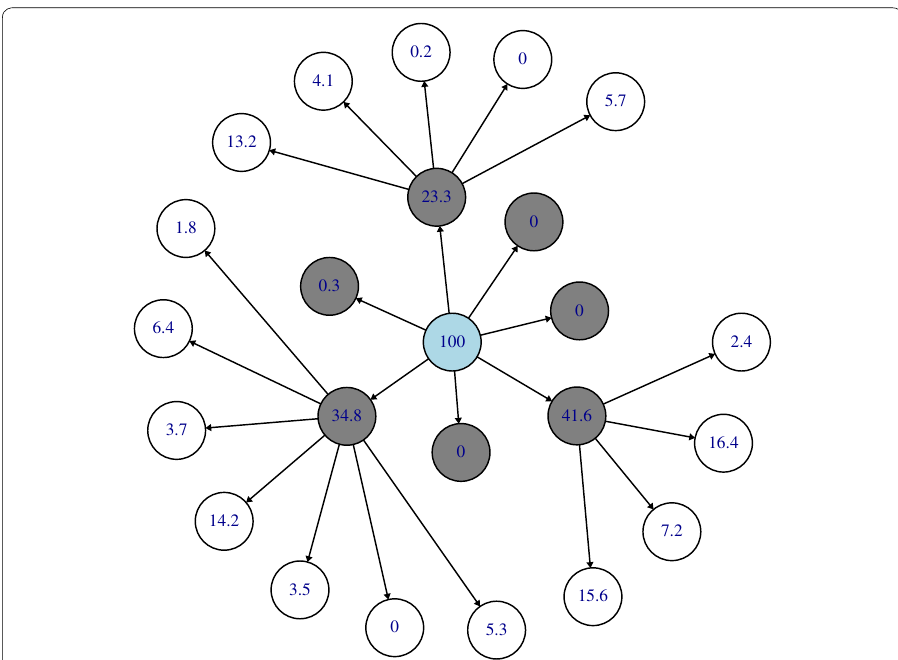
Fig. 10 Tree diagram for the image shown in Fig. 7. The number in each bubble indicates the percentage of pixels contained in the corresponding